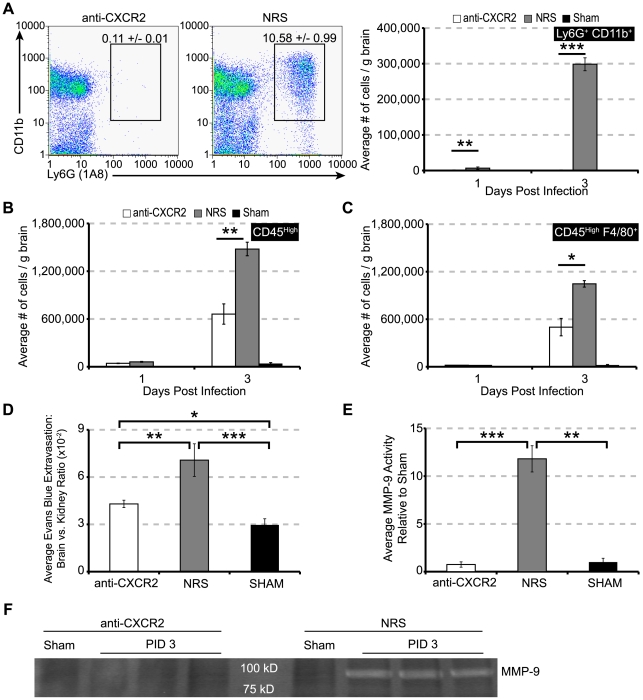
CXCR2 neutralization prevents CNS PMN infiltration and abrogates BBB breakdown.C57BL/6 mice i.c. infected with 500 PFU JMHV were pretreated with CXCR2 neutralizing antiserum or control NRS every other day beginning at day -1 p.i. Brains were removed at days 1 and 3 p.i. to assess cellular infiltration, Evans Blue (EB) extravasation, or MMP activity. CXCR2 neutralization significantly reduced (A) the frequency and total numbers of neutrophils within the brain at day 1 and 3 p.i. The infiltration of (B) CD45high-expressing cells and (C) macrophages was also significantly reduced at day 3 p.i. Concomitant with the absence of PMN accumulation, CNS EB extravasation (D) was significantly reduced compared to NRS-treated mice, although BBB permeability was greater than sham mice. Additionally, MMP9 activity was undetectable in anti-CXCR2 treated brains compared to NRS-treated mice (F). Quantification of MMP9 activity revealed a significant increase in MMP9 activity compared to both sham and infected mice treated with CXCR2 antiserum (E). Data in panels A
–
F represents 2 independent experiments with a minimum of 3 mice per time point for each experimental group. For panel F, each lane represents an individual mouse. *p<0.05, **p<0.01, ***p<0.001 compared to NRS-treated mice.